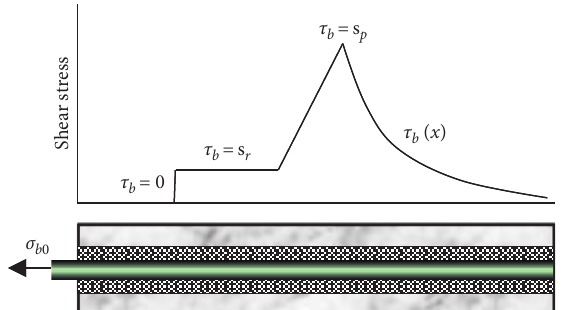
Figure 1: Distribution of shear stress along a fully grouted rock bolt subjected to an axial load in a coupled rock bolt [6].